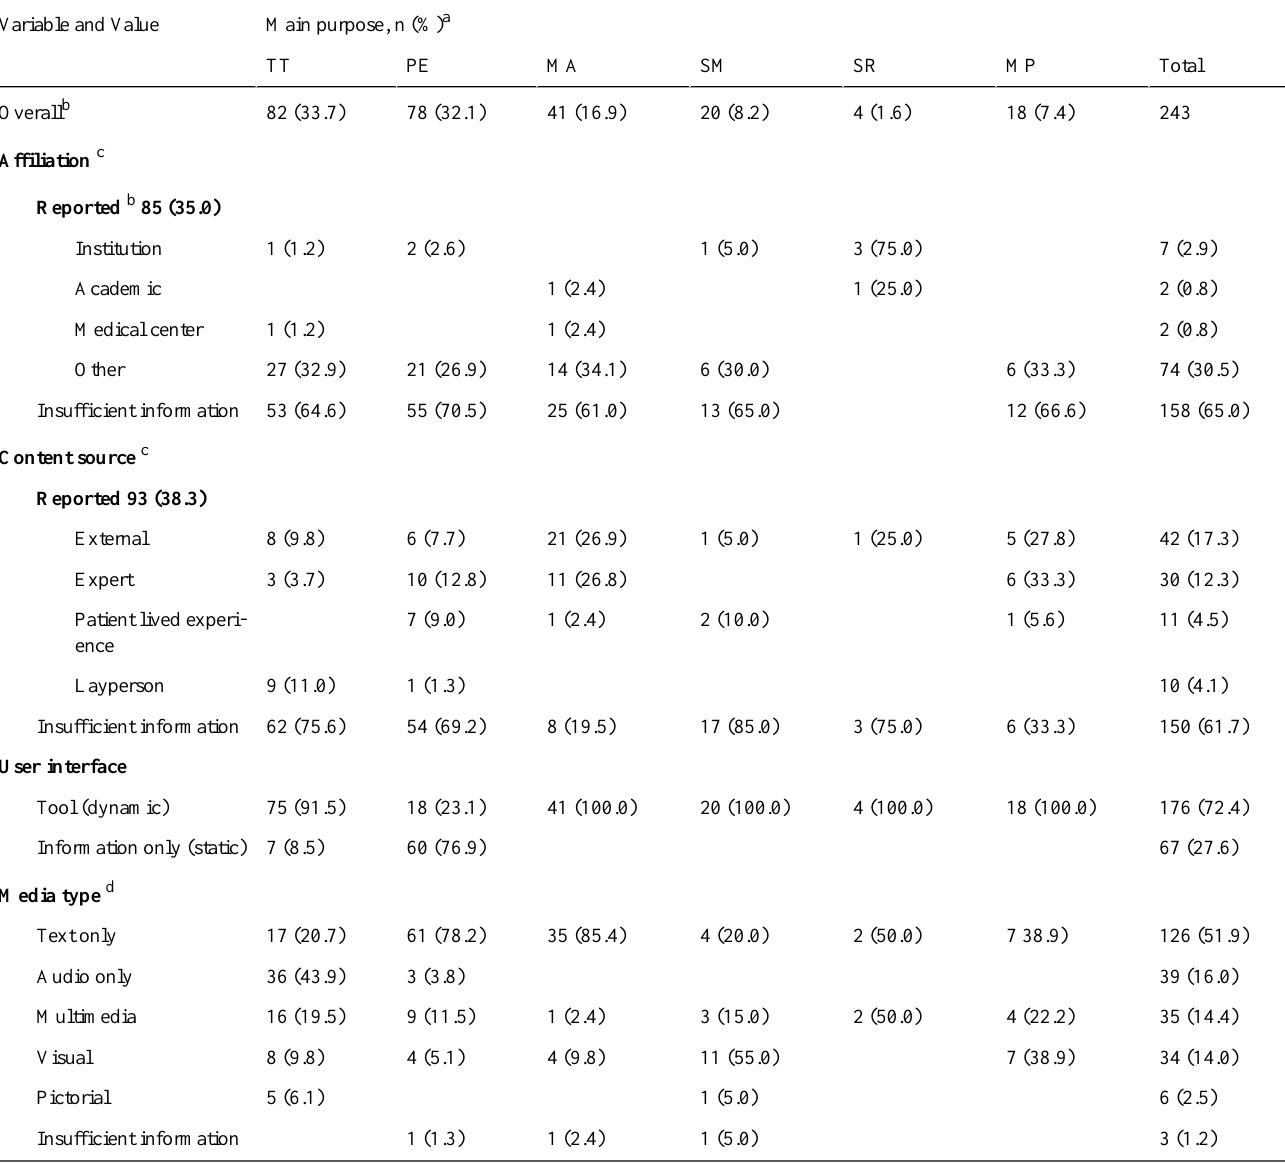
Table 2. Distribution of depression apps by variable and main purpose.